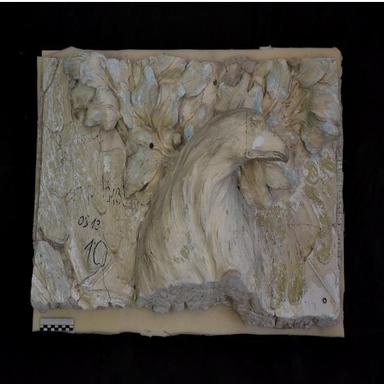
Fragment of stucco representing an eagle, detached from the wooden ceiling of the Gallery of the Angels. It measures 48x81x22 cm and weights 30.16 kg.